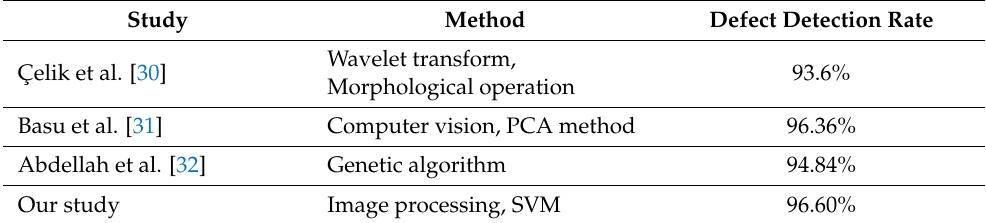
Table 3. Comparison with our related study.